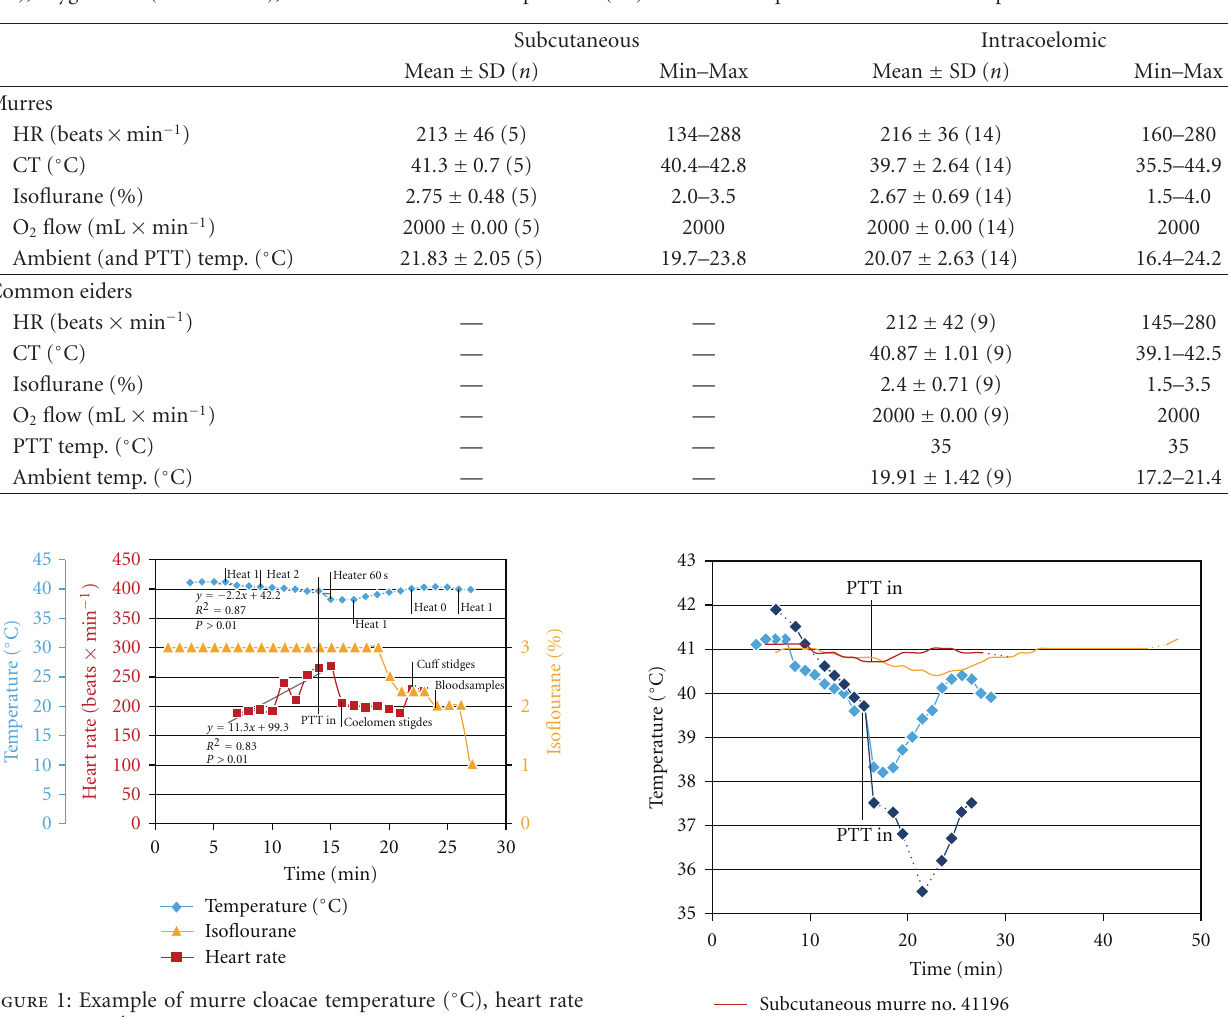
Table 1: Basic statistics (Mean ± SD, range) for continuously measured heart rate (HR), cloacae temperature (CT), Isoflurane concentration (Iso), oxygen flow (mL × min − 1 ), and ambient and PTT temperature ( ◦ C) divided on implantation method and species.